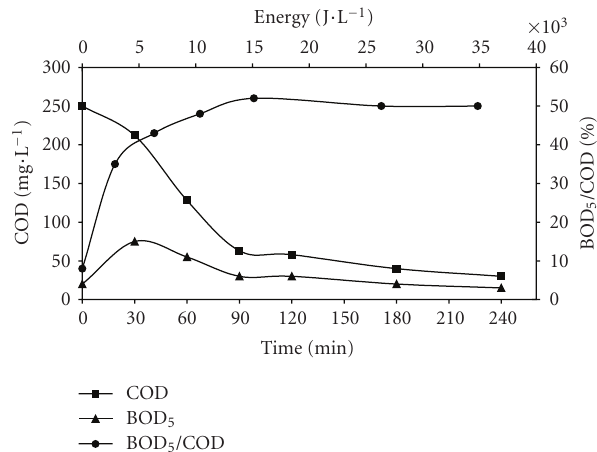
Figure 7: Evolution of biochemical parameter of the Endosulfan polluted water during the helio-photoFenton treatment, ( (cid:2) ) for the COD, ( (cid:3) ) for BOD 5 , and ( • ) for the BOD 5 /COD